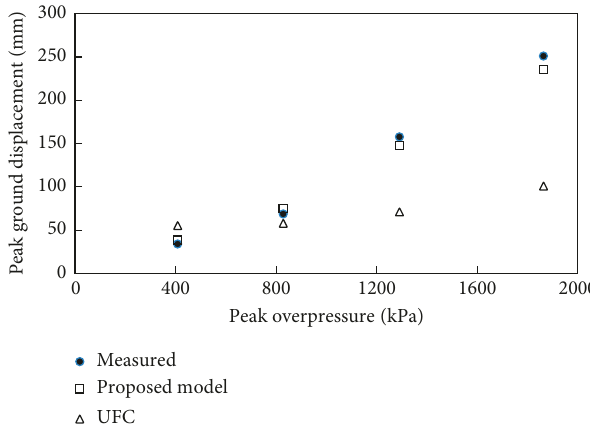
Figure 9: Comparison between measured and estimated peak ground